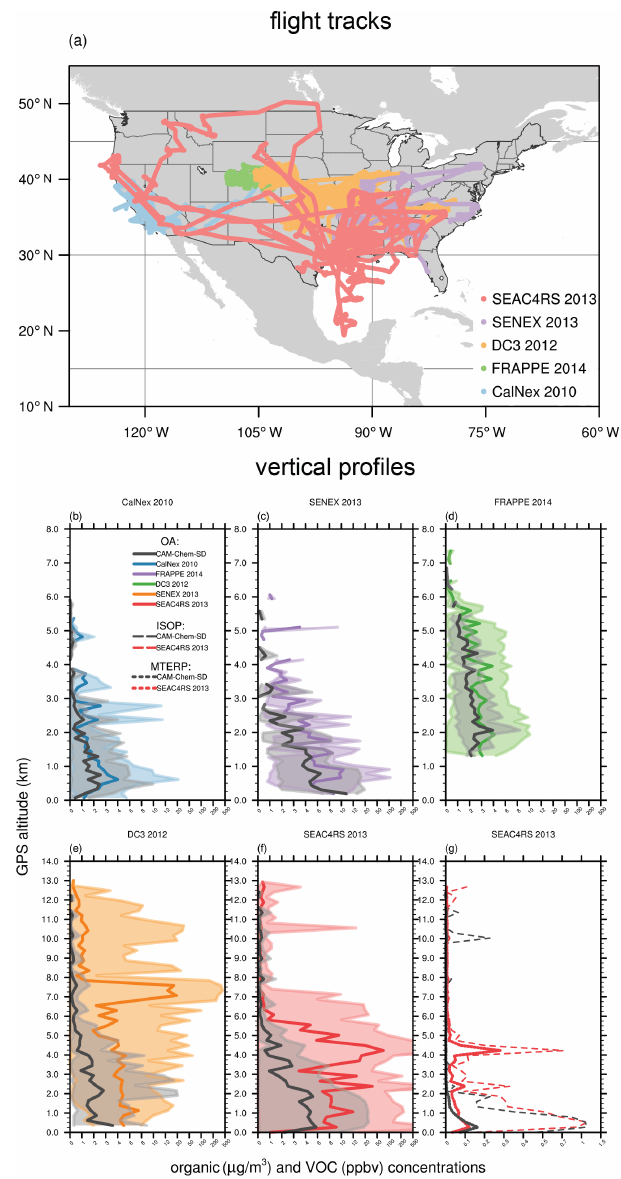
Figure 3. Flight tracks of five aircraft campaigns (a) and vertical profiles of average OA (solid lines, panels b–f ), ISOP (dashed lines, panel g ), and MTERP (dotted lines, panel g ) concentrations from CAM-Chem-SD (black), CalNex (blue), SENEX (purple), FRAPPE (green), DC3 (orange), and SEAC4RS (red) flight campaigns. The range of OA concentrations at each layer is shown as the shaded area or dashed